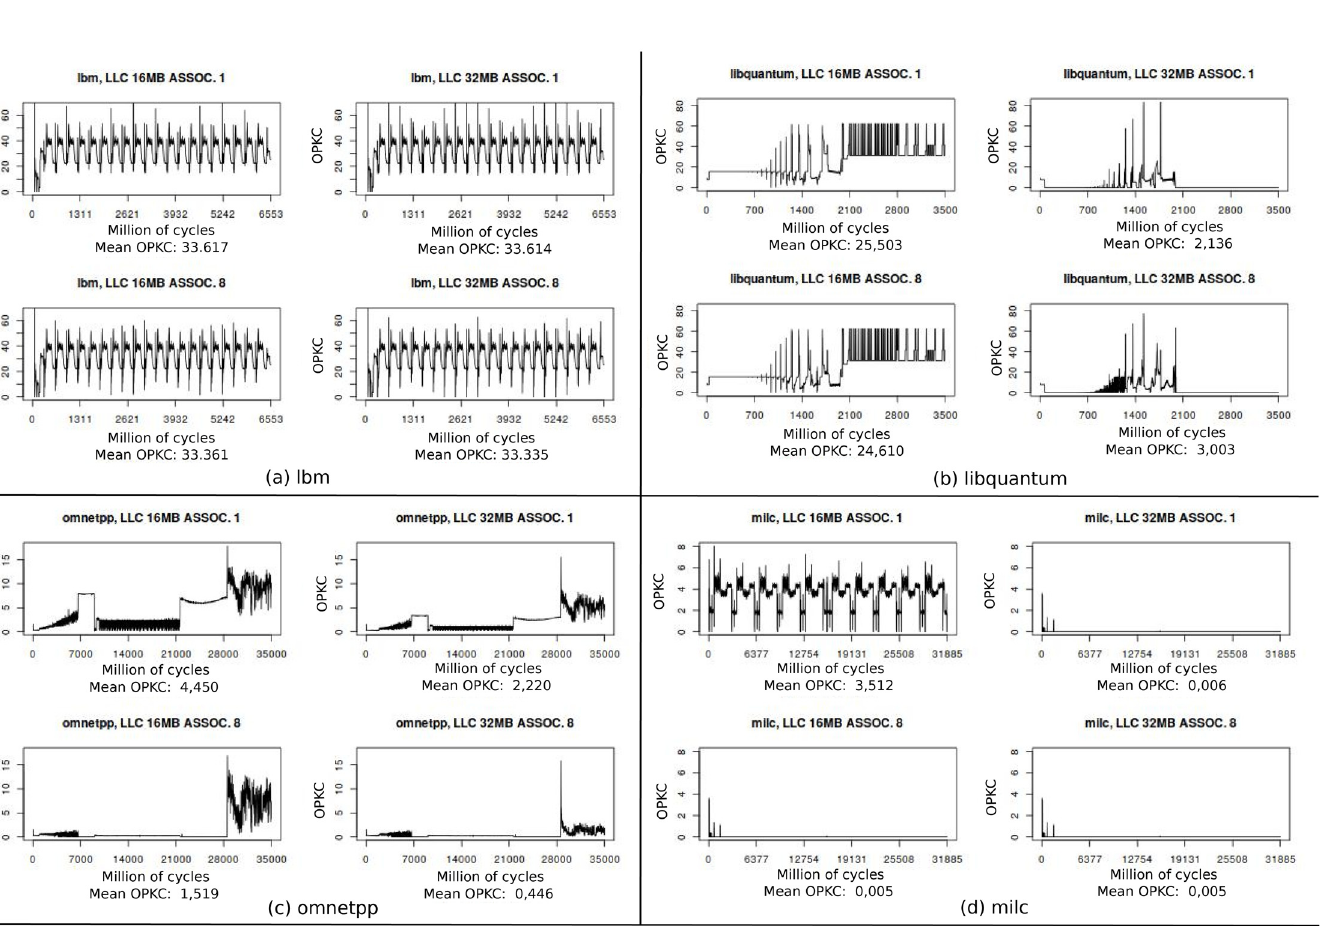
Fig 3. Analysis of spatial locality in mcf benchmark. Spatial locality is modeled using off-chip OPKC , so when OPKC increases hit ratio in external cache becames critical. In (a) can be seen how starting on cycle 1100-Million OPKC increases in all LLC configurations. (b) shows how starting on cycle 1100-Million our proposal HMM achieves very good hit ratio when off-chip cache presure increases, beating clearly G / DC prefetch technique in this scenario.